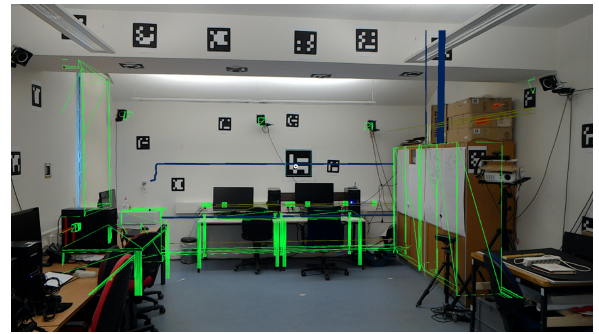
Figure 4. The real room augmented by the room model from Figure 2 after localizing the HoloLens via the ArUco marker shown in Figure 3.